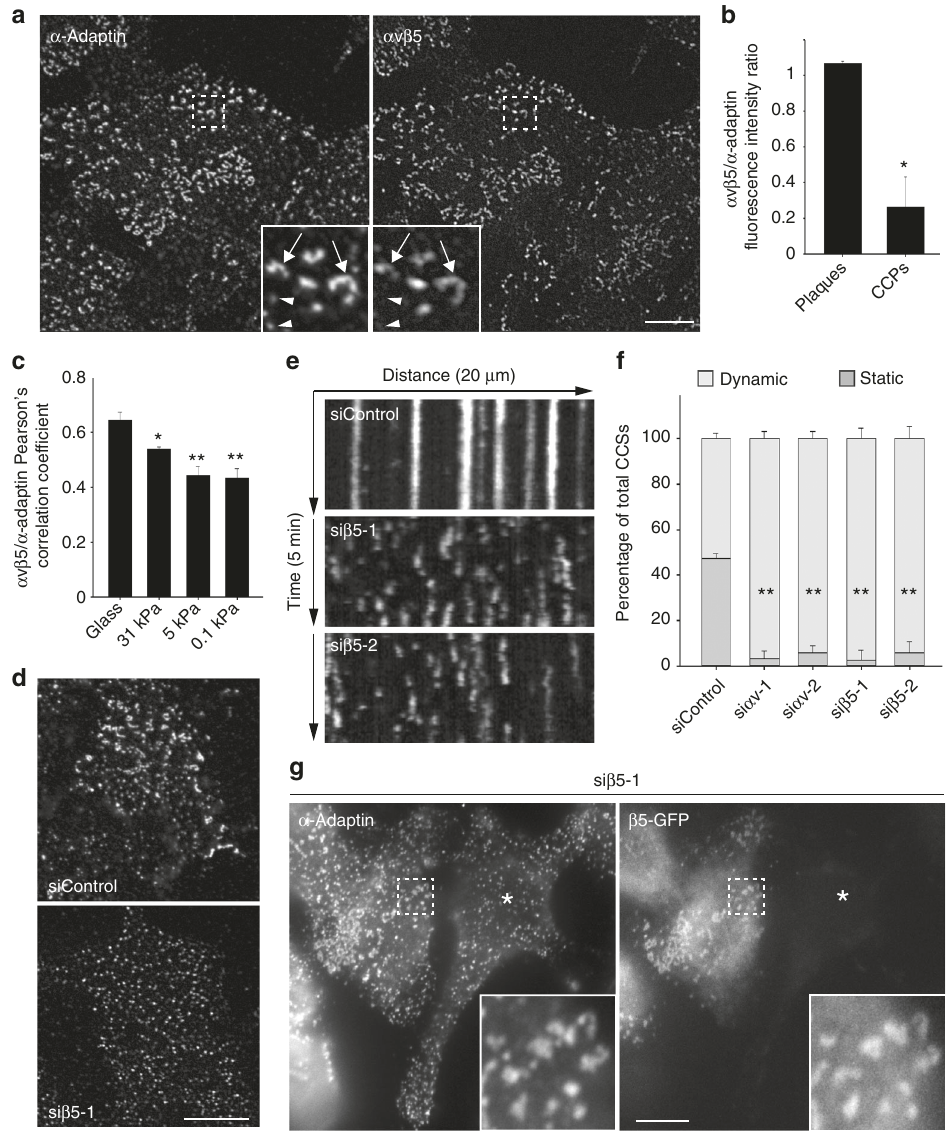
Fig. 2 α v β v5 integrin localizes to plaques and is required for their assembly. a HeLa cells were seeded on collagen-coated glass and fi xed 24 h later before being stained for α -adaptin and α v β 5-integrin. Scale bar: 10 µ m. Higher magni fi cations of boxed regions are shown. Arrows point to clathrin-coated plaques; arrowheads point to CCPs. b Quanti fi cation of α v β 5 enrichment at plaques versus CCPs (* P < 0.005, two tailed Student ’ s t -test. n = 3; 100 structures per experiment were counted.). c Quanti fi cation of colocalization (Pearson ’ s coef fi cient) between α v β 5 and α -adaptin in cells cultured on the indicated collagen-coated substrate (* P < 0.005; ** P < 0.001, one-way analysis of variance — ANOVA. n = 3). d HeLa cells treated with control (upper panel) or β